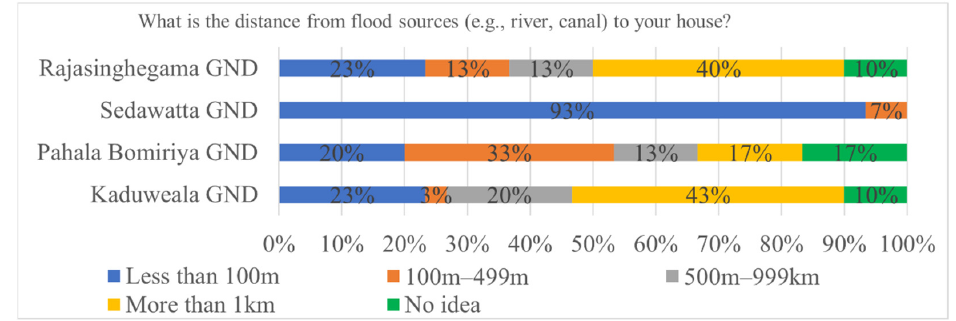
Figure 2. Distance from flood sources (e.g., river, canal) to respondents’ houses.